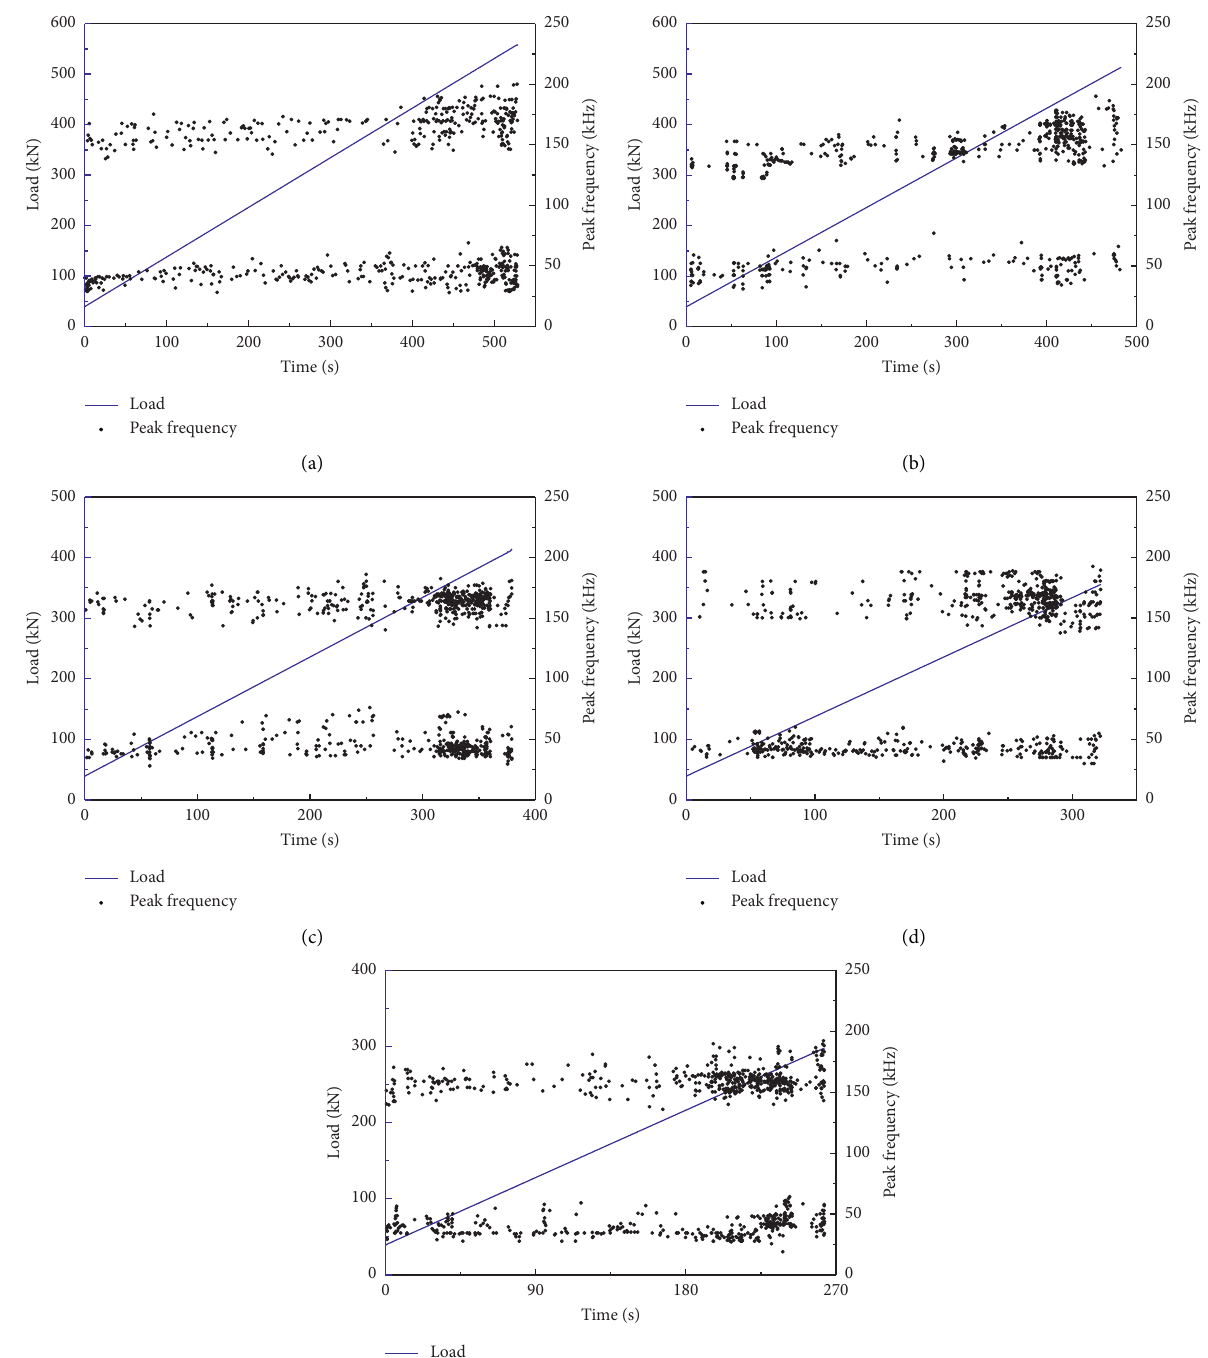
Figure 6: Relationship between load and time and peak AE frequency of each group of granite samples under triaxial compression. (a) 0 freeze-thaw cycles, (b) 10 freeze-thaw cycles, (c) 30 freeze-thaw cycles, (d) 60 freeze-thaw cycles, and (e) 90 freeze-thaw